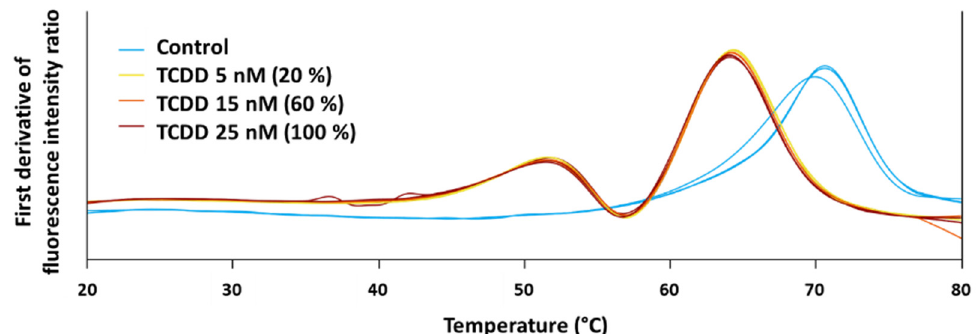
Figure 3. Melting temperatures obtained from nanoDSF protein-chemical binding validation for the interaction of HSPB1 with TCDD at 5 nM (20%) (yellow), 15 nM (60%) (orange), and 25 nM (100%) (red). A control without TCDD was included (light blue). (For interpretation of the references to color in this figure legend, the reader is referred to the web version of this article).